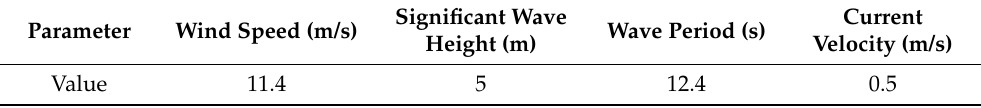
Table 3. Parameters of environmental conditions in this paper.